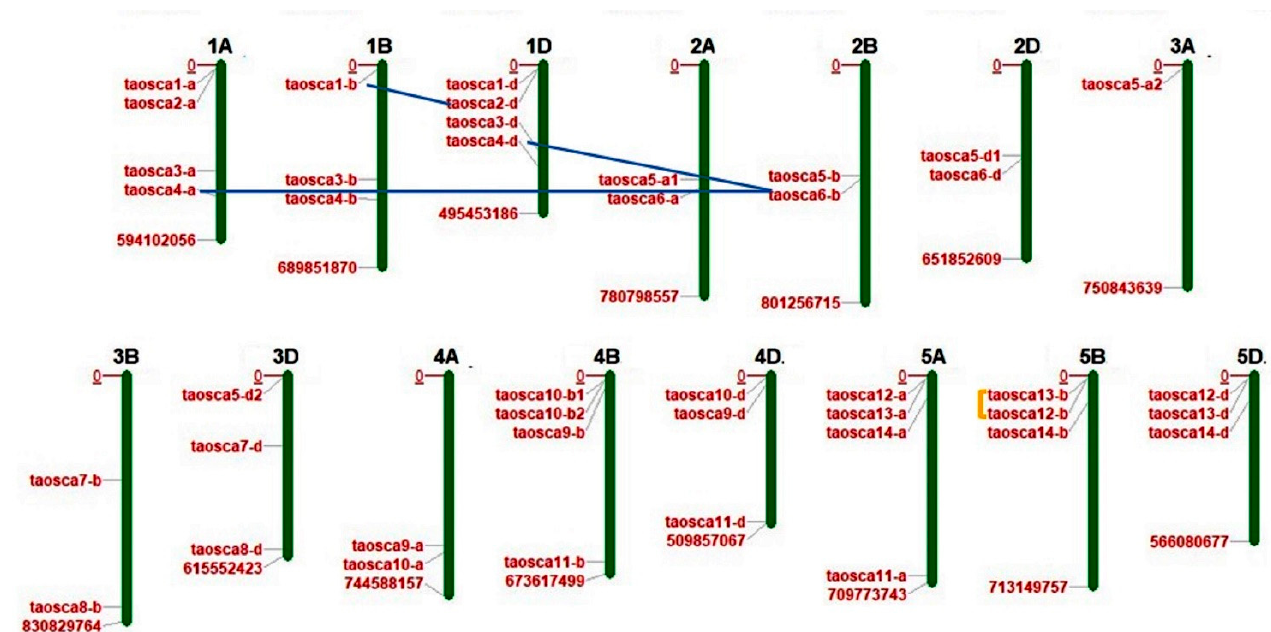
Figure 1. Chromosomal localization and duplication analysis of OSCA genes in Triticum aestivum. The TaOSCA genes are distributed on a total of 15 chromosomes of the A, B, and D subgenomes of T. aestivum. Blue lines point toward the existence of segmentally duplicated genes and yellow delineated shapes indicate the existence of tandemly duplicated gene pairs.